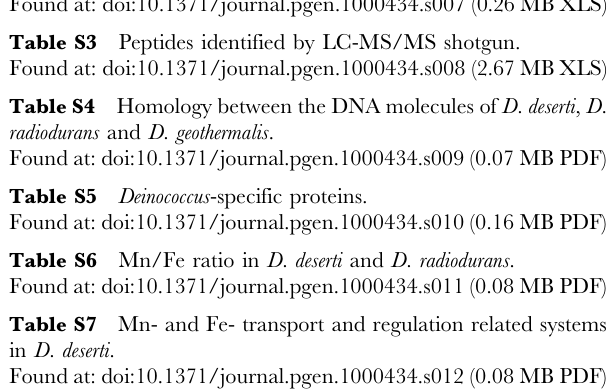
Table S8 Stress response-related proteins in D. deserti , D. radiodurans and D. geothermalis . Table S9 ABC-transporters identified in D. deserti . Table S10 DNA repair genes in D. deserti , D. radiodurans and D. geothermalis . Table S11 Radiation/desiccation response motif identified in D. Table S12 Primers for